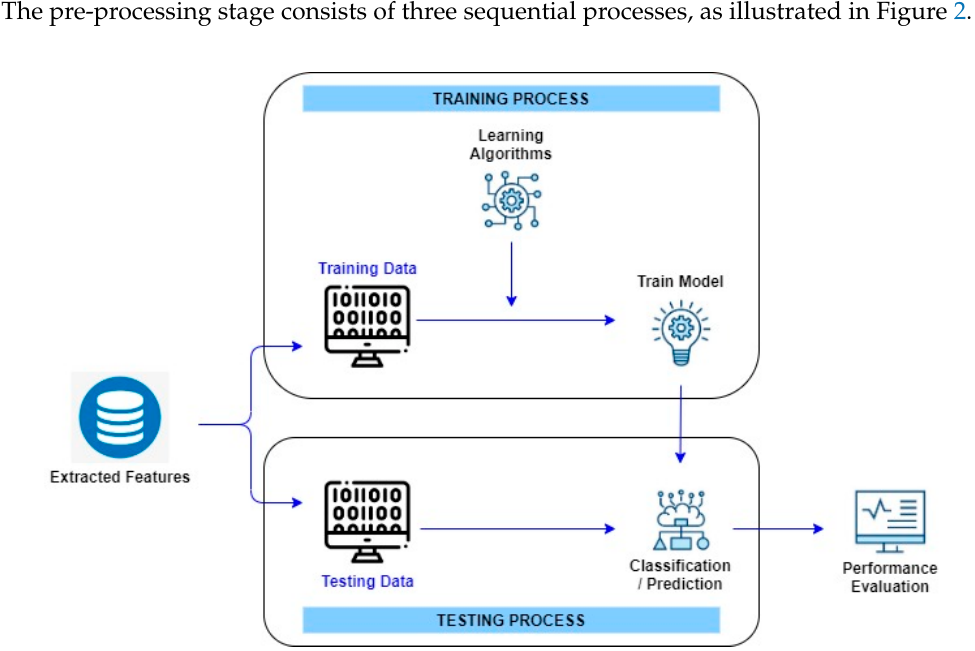
Figure 2. Illustration for Training and Testing Process.